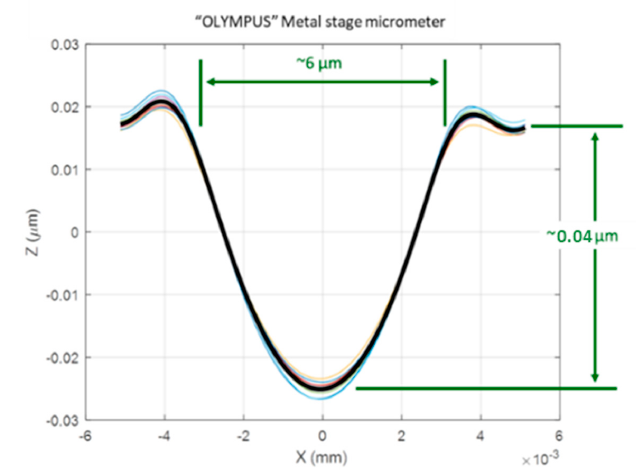
Figure 13. Grooves dimensions of commercial stage micrometer.